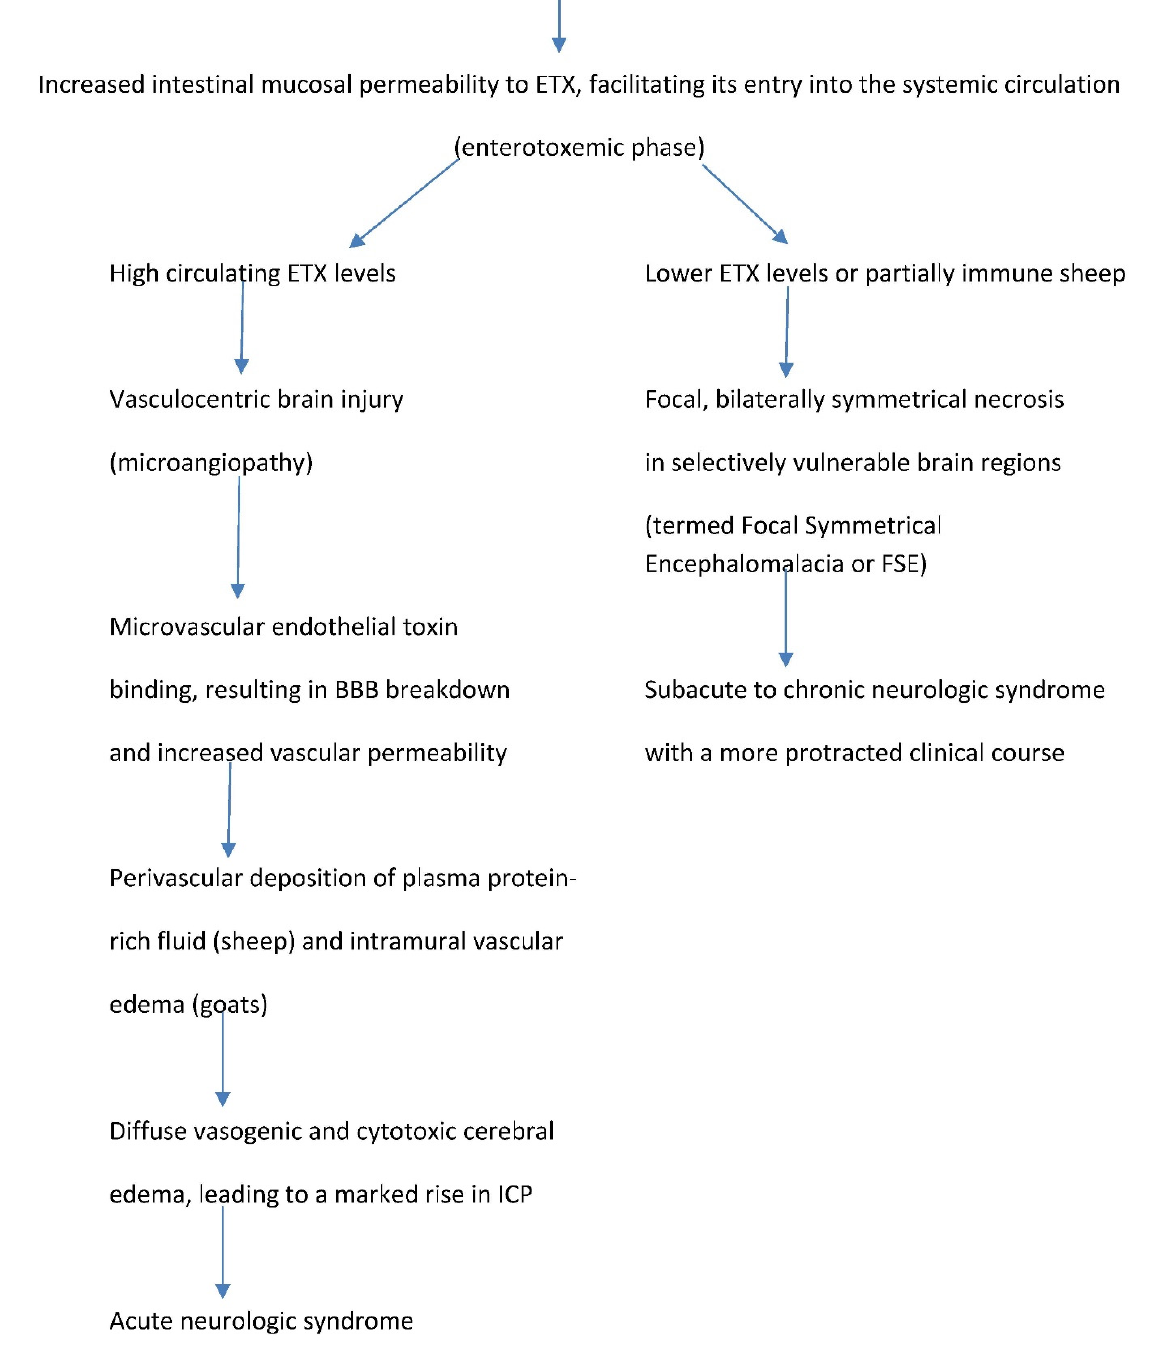
Figure 1. Pathogenesis of Clostridium perfringens type D epsilon toxin neurotoxicity in ruminant live- stock.